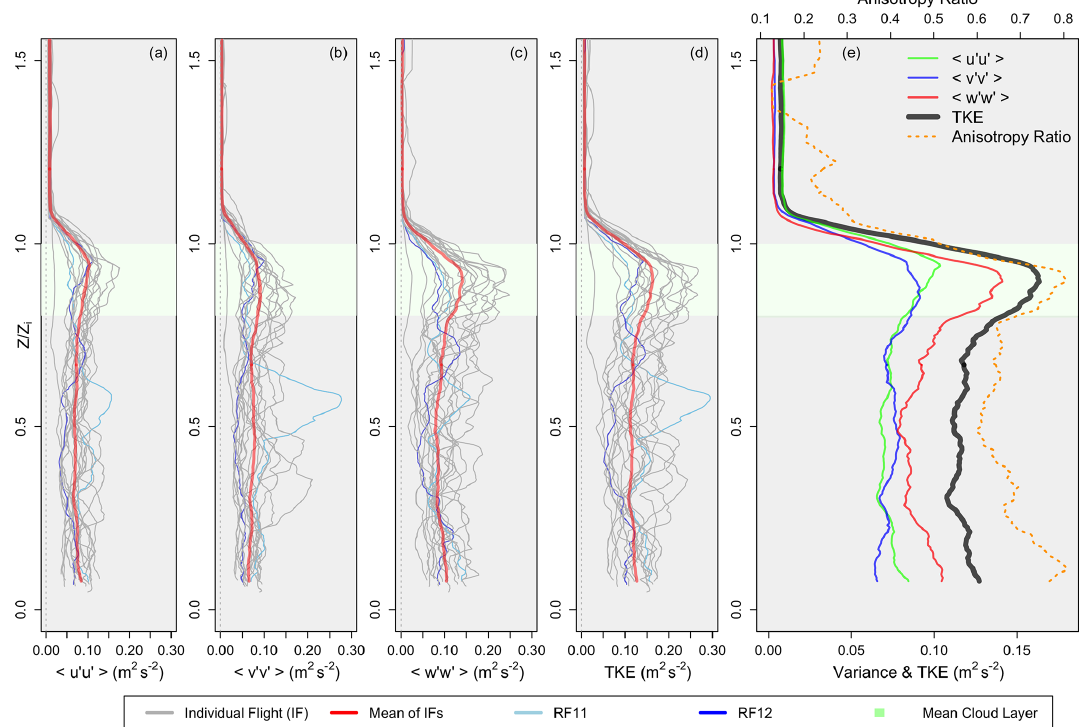
Figure 10. Vertical profiles (from data collected during flight profiles) of (a) u variance (m 2 s − 2 ), (b) v variance (m 2 s − 2 ), (c) w variance (m 2 s − 2 ), and (d) TKE (m 2 s − 2 ). Individual flights are displayed in gray, and the mean value is displayed in red, with RF11 and RF12 shown in light blue and dark blue, respectively. (e) Mean values from (a) through (d) , along with the anisotropy ratio in